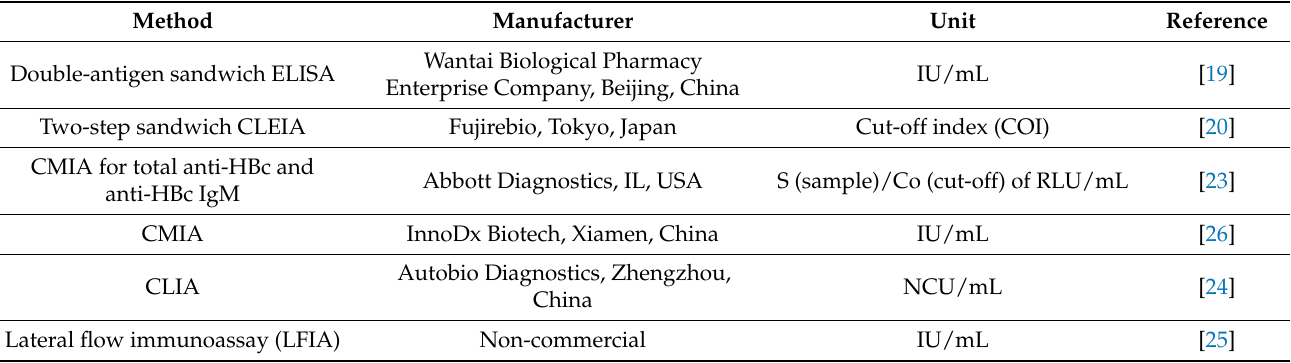
Table 1. Methods and units used for anti-HBc antibodies